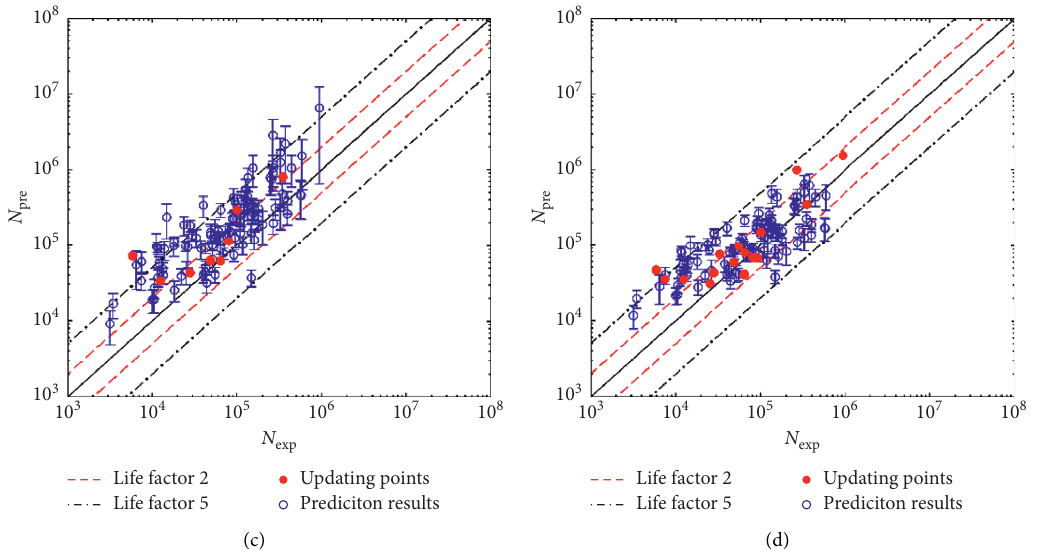
Figure 12: Fatigue life prediction results for 12mm-diameter bars using the model updated with (a) 1 point, (b) 4 points, (c) 8 points, and (d) 16 points.